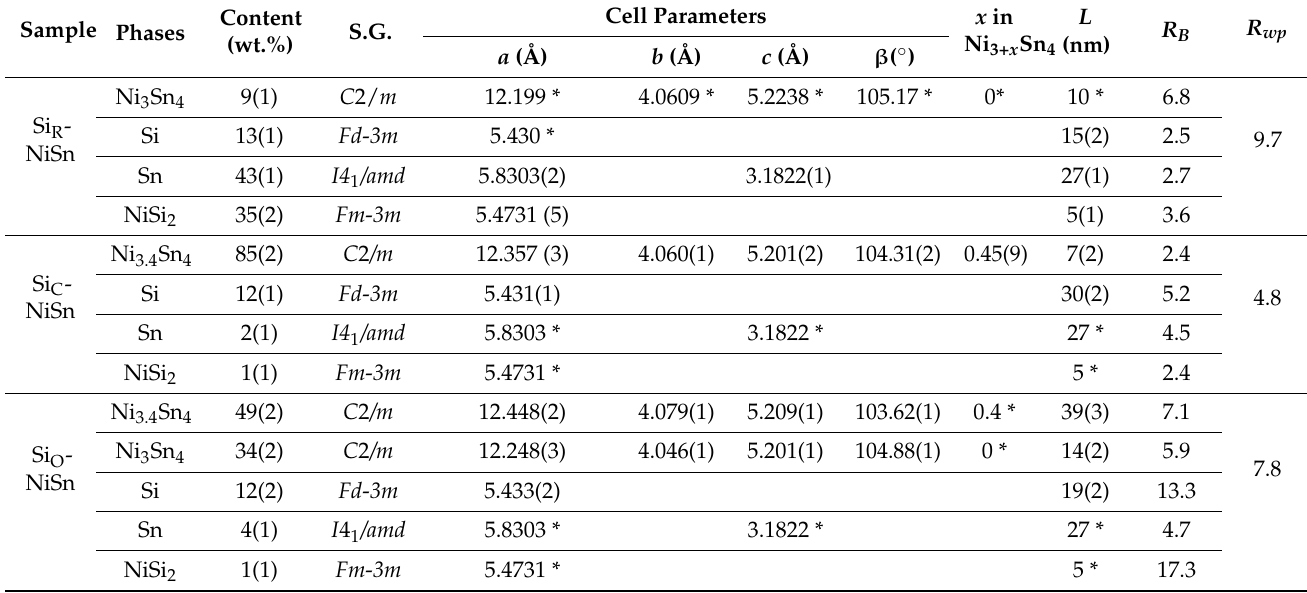
Table 2. Crystallographic data for the Si R -NiSn, Si C -NiSn and Si O -NiSn composites after 20 h of milling as determined from Rietveld analysis. Ni over-stoichiometry (x) in Ni 3+x Sn 4 and crystallite size (L in nm) for all phases are given. Standard deviations refereed to the last digit are given in